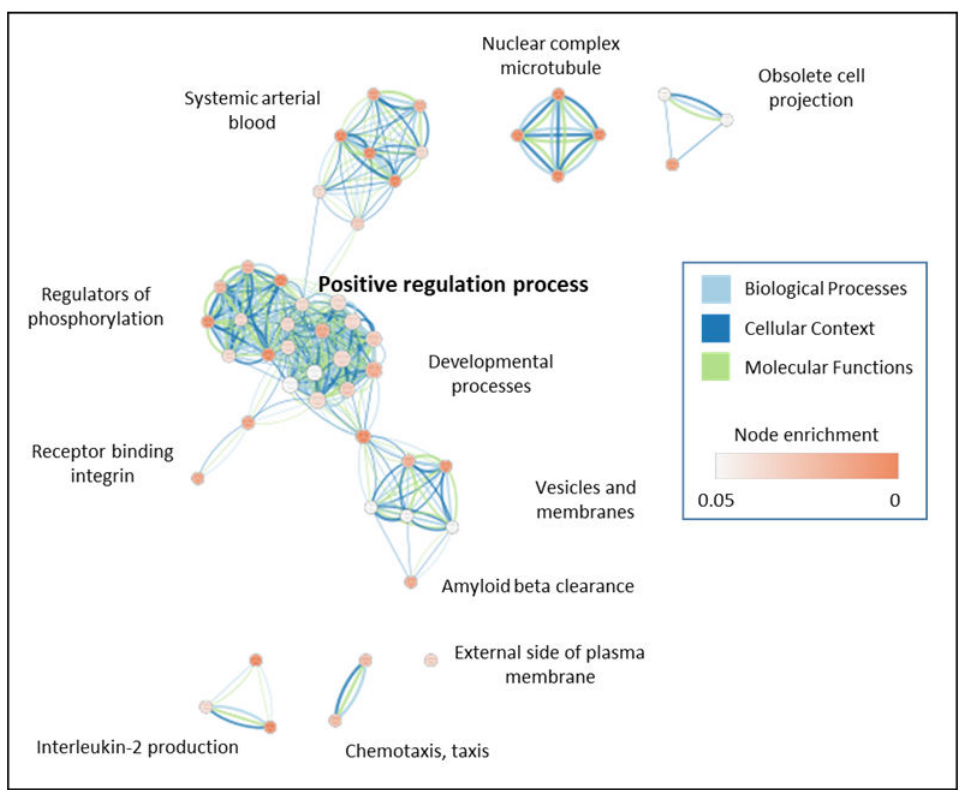
Figure 7. Representative biological and molecular networks derived from the TCGA dataset. Enrichment results were mapped as a network of gene sets (nodes) related by mutual overlap (edges), where the intensity in color indicates the level of enrichment of gene set. Node colour is proportional to the level of enrichment in each set and line color represents the pathways